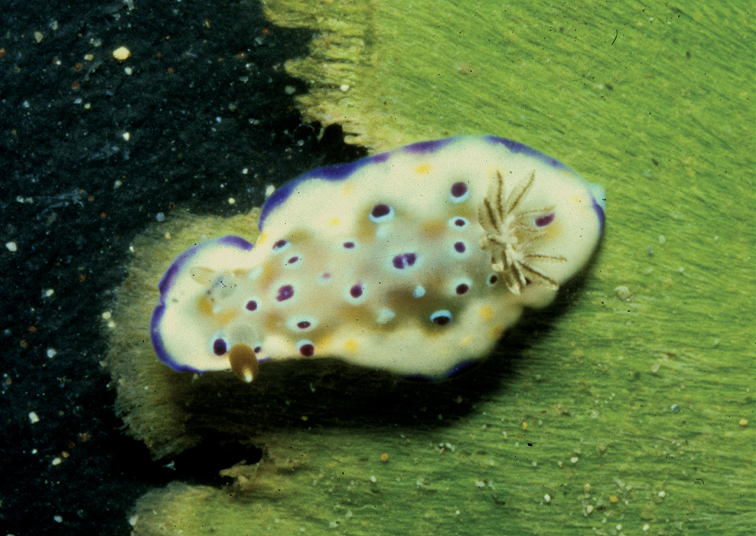
Chromodoris tennentana, 10 mm, Madagascar, photo: J Hinterkircher (no spcm).